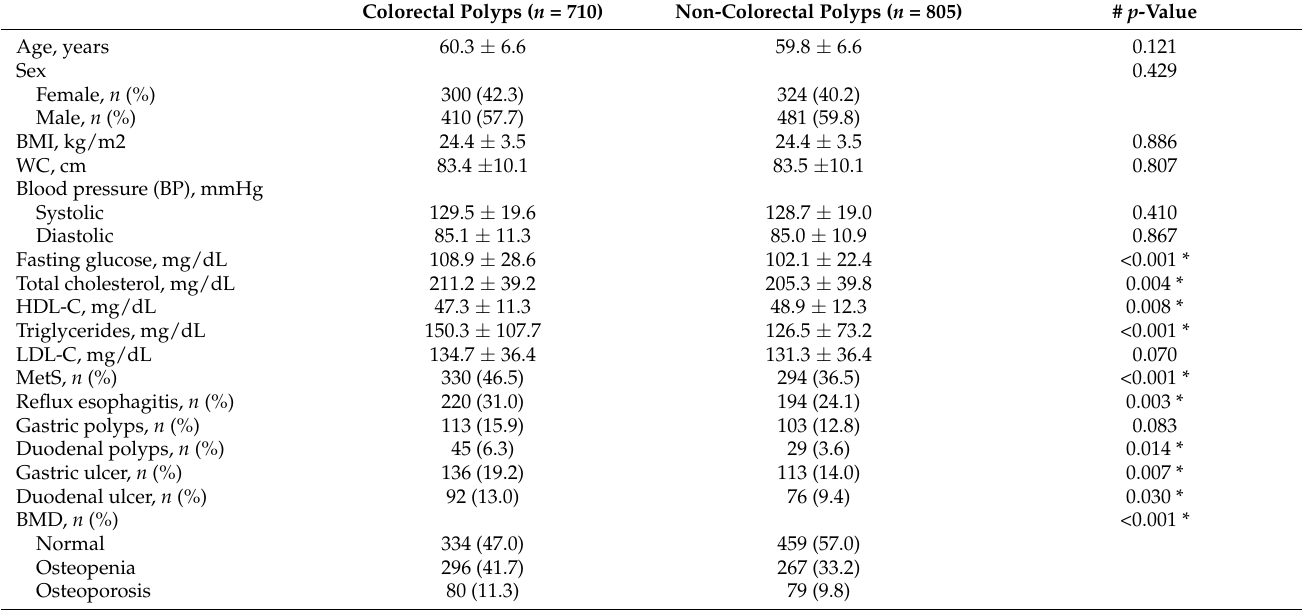
Table 1. Differences between colorectal polyps group and non-colorectal polyps